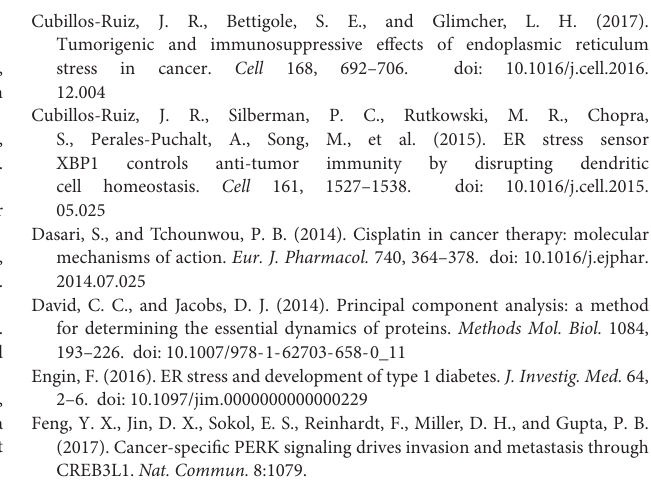
GBM patients in two clusters. Supplementary Figure 2 | K-M survival analysis of the risk signature in glioma patients stratified by IDH mutation status, MGMT promoter methylation and 1p/19q co-deletion status in TCGA and CGGA datasets. Supplementary Figure 3 | A nomogram model for predicting overall survival of patients with glioma. (A) A nomogram model was constructed by integrating the clinicopathologic features and risk score of patients in the TCGA dataset. (B,C) The calibration curve of nomogram for predicting OS at 1-, 3- and 5-years in the TCGA and CGGA datasets. Supplementary Figure 4 | GSEA analysis was performed to investigate the biological functions and pathways that were tightly correlated with the ER stress activation. Supplementary Figure 5 | The ER stress activation related immunologic events in glioma samples in CGGA dataset. (A–C) Correlation analysis between risk score signature and immune checkpoints in whole gliomas, low-grade gliomas and GBM, respectively. (D–F) Correlation analysis between risk score and inflammatory genes in whole grade of gliomas, low-grade gliomas and GBM, respectively. (G) CIBERSORT evaluating the proportion of various types of immune cell infiltrated into glioma samples. (H) Correlation analysis between risk score and biomarkers of monocytes and macrophages. Supplementary Figure 6 | K-M survival analysis of each independent gene in the ER stress-related signature in TCGA and CGGA datasets. Supplementary Figure 7 | ER stress activation promotes migration and proliferative capacity of glioma cell lines in vitro . (A,B) Cell scratch assay of U87 and LN229 cell lines treated with PDIA4 siRNA, P4HB siRNA and negative control. (C,D) Clonogenic assay of U87 and LN229 cell lines treated with PDIA4 siRNA, P4HB siRNA and negative control. Supplementary Table 1 | Characteristics of patients in cluster 1 and cluster 2 in CGGA databset. Supplementary Table 2 | ER stress related gene list. Supplementary Table 3 | Univariate Cox analysis of ER stress-related genes. Supplementary Table 4 | Univariate and multivariate analysis of OS in CGGA sequencing